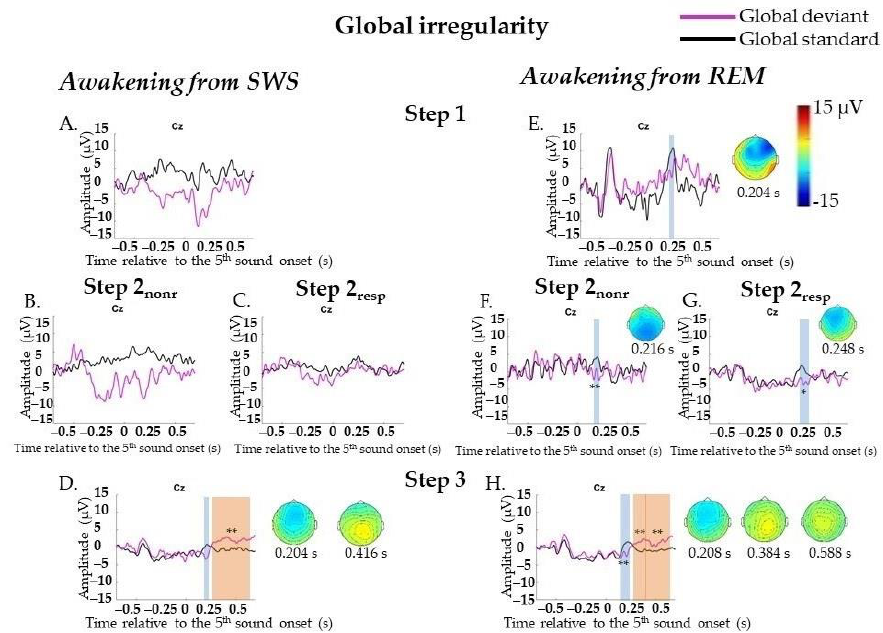
Figure 4. Event-related responses to violation of global regularity in the sessions with awakening from slow-wave sleep and rapid eye movement sleep. SWS, slow-wave sleep; REM, rapid eye movement sleep; Step 1, period of awakening when delta or theta prevail in EEG, the motor response is absent; Step 2 nonr , period of awakening when alpha prevails in EEG, the motor response is absent; Step 2 resp , period of awakening when alpha prevails in EEG, the motor response is slow; Step 3, period of awakening when alpha prevails in EEG, the motor response is accurate and timely; s, second; magenta line, averaged global deviants; black line, averaged global standards; global effect, global deviants minus global standards. ( A – D ) The sessions with awakening from SWS for all Steps separately. ( E – H ) The sessions with awakening from REM for all Steps separately. The blue-shaded region is a pool of negative clusters. The orange-shaded region is a pool of positive clusters. * p < 0.025, ** p < 0.01. Topographies of global effect are shown for the maximum of ERP peak amplitude. The data, which were not replicated in Two-way ANOVA, are not marked with